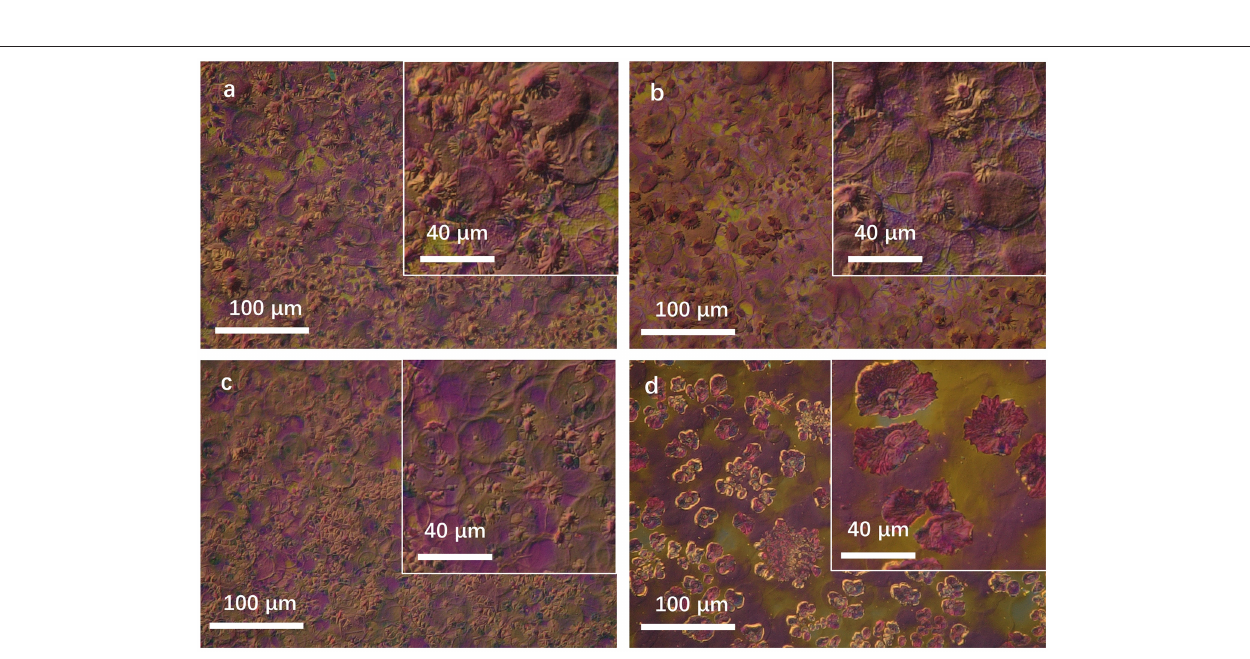
FIGURE 6 | 3D opt-digital microscope image for PBDB-T-2Cl:IT4F blend films using varied solvents. (a) 100% CB, (b) 80% CB + 20% benzene, (c) 80% CB + 20% TMB, and (d) 80% CB + 0% TEB.